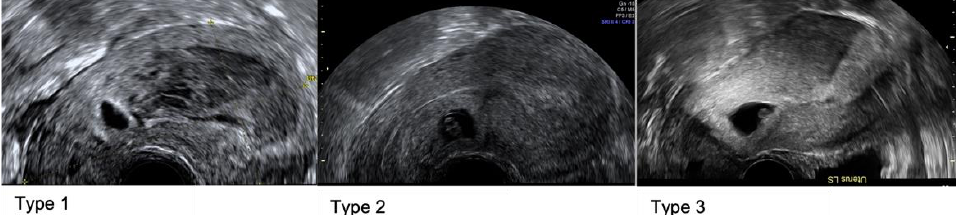
Figure 1. Caesarean Scar Pregnancy types as per Delphi consensus: Type 1 where the largest part of the gestational sac (GS) protrudes towards the uterine cavity; Type 2 where the largest part of the GS is within the myometrium but not breaching the serosa, and Type 3 where the pregnancy is partially located outside of the contour of the cervix or uterus.